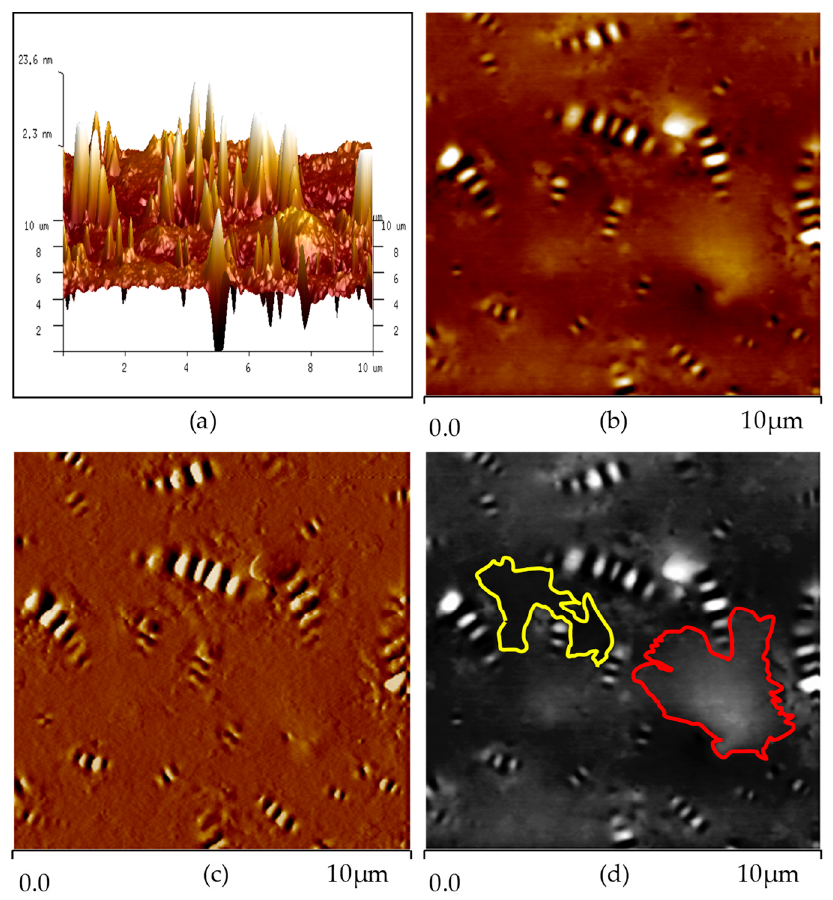
Figure 4. Atomic force microscope (AFM) images of bitumen without ageing. ( a ) three-dimensional height image; ( b ) Two-dimensional height image; ( c ) amplitude image; ( d ) Phase image.